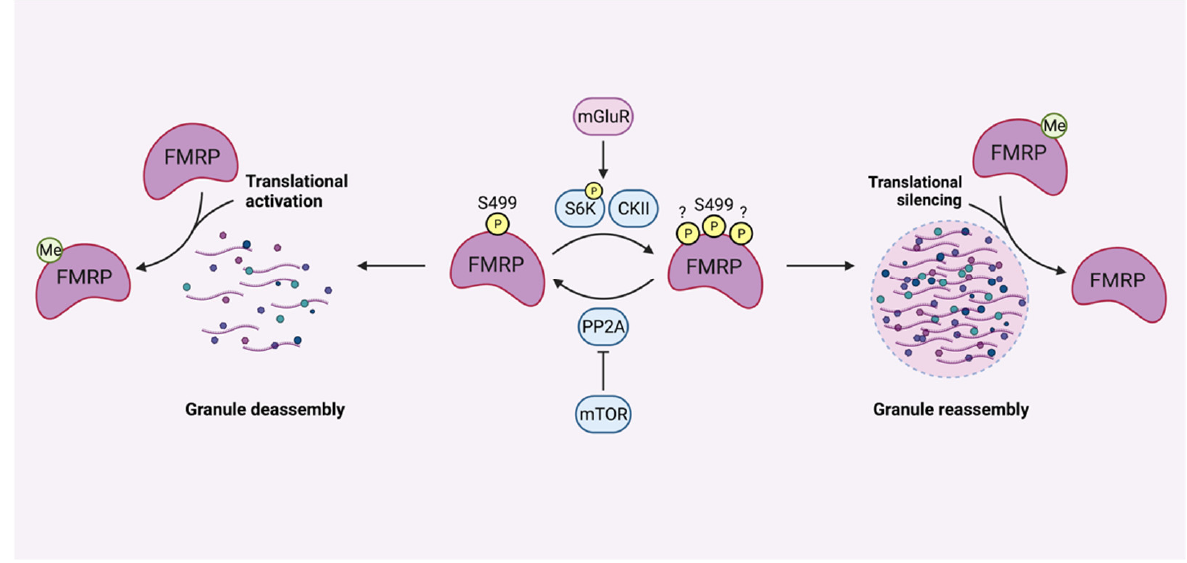
Figure 3. Kinase-phosphatase regulation of the Fragile X Mental Retardation Protein. FMRP is reg- ulated by a kinomic network and exists in two biochemical states, being phosphorylated by riboso- mal protein S6 kinase 1 (S6K1) or dephosphorylated by protein phosphatase 2A (PP2A). Other post- translational modifications, such as methylation, ensure neuronal granule disassembly and transla- tional activation. However, S6K1 phosphorylation promotes FMRP demethylation and facilitates granule formation by high-complexity protein interactions.